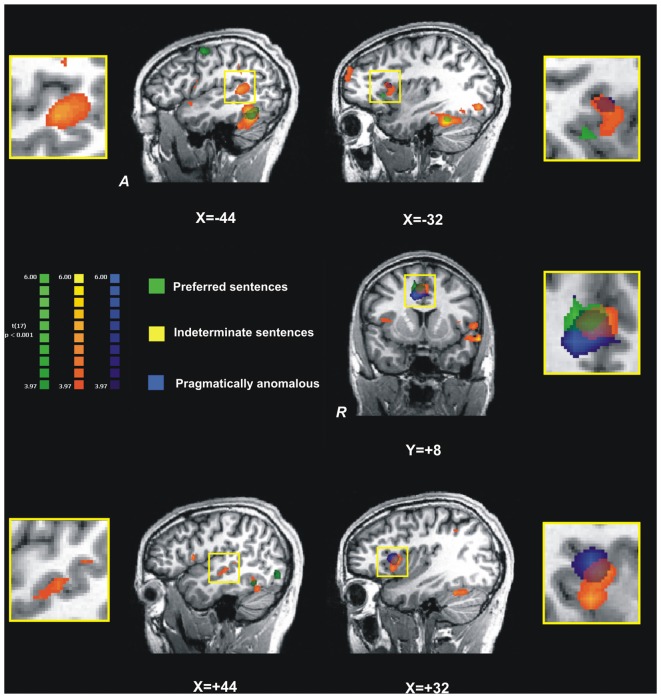
The overlap and spatial differences between activation maps (changes in BOLD signal) for the three main sentence conditions, preferred (green clusters), indeterminate (orange clusters), and pragmatically anomalous (blue clusters) in five regions-of-interest. Left STG and IFG are shown in top row; the anterior cingulate cortex (ACC), in the middle; and right STG and IFG in the bottom row. In the left and right STG we observe a greater activation for indeterminate sentences, with no overlap with the other sentence types; however, in the IFG, both on the right and left there is overlapping with preferred sentences. In the left IFG (top right) there is greater activation for indeterminate (BA 44) but overlapping with pragmatically anomalous (see insert); a ventral region of BA 44 shows greater sensitivity for preferred sentences. In ACC we observe overlapping activations, with indeterminate sentences activating a more anterior area, while preferred and pragmatically anomalous sentences activate more the posterior parts of ACC; all activated regions in the ACC are more right-lateralized. In the right STG we observe significant activation for indeterminate sentences only, and in the right IFG we note common and distinct activations for both pragmatically anomalous and indeterminate sentences but not preferred. X and Y values indicate coordinates in Talairach space. ACC, anterior cingulate cortex; IFG, inferior frontal gyrus; STG, superior temporal gyrus.